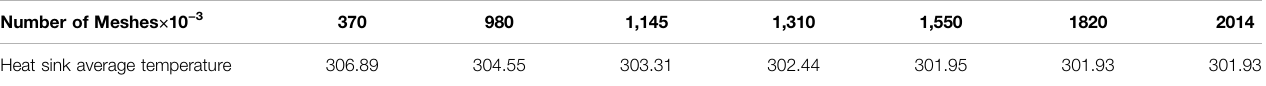
TABLE 1 | Average temperature changes of heat sink for different elements at Re (cid:1) 300 for Fi (cid:1) 5%. Number of Meshes × 10 − 3 370